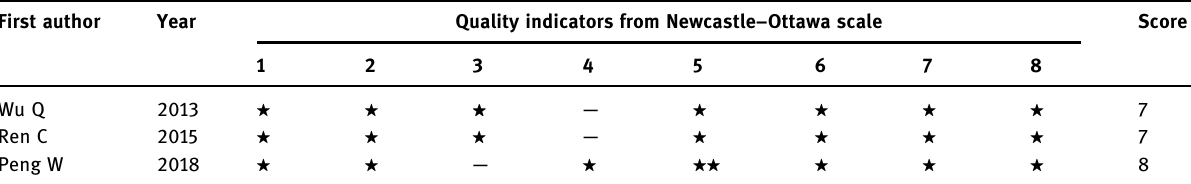
Table 3: Newcastle – Ottawa quality assessment